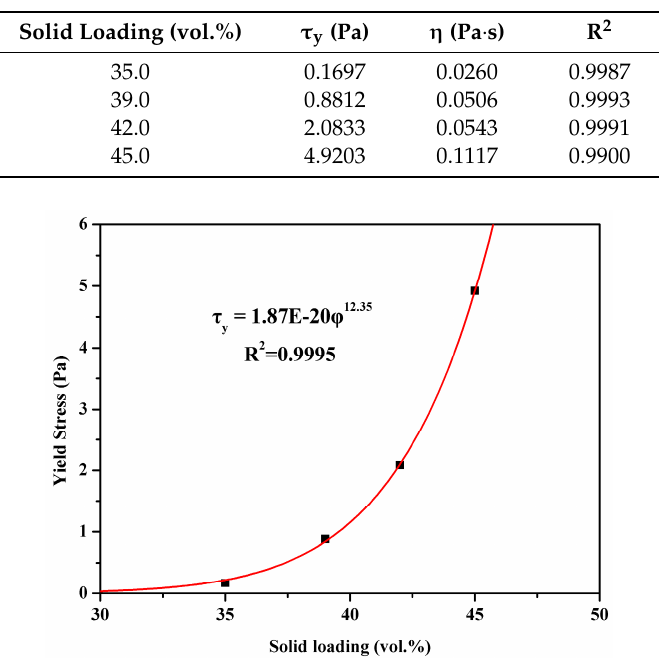
Figure 5. The power law dependence of the suspension yield stress on the solid loading.